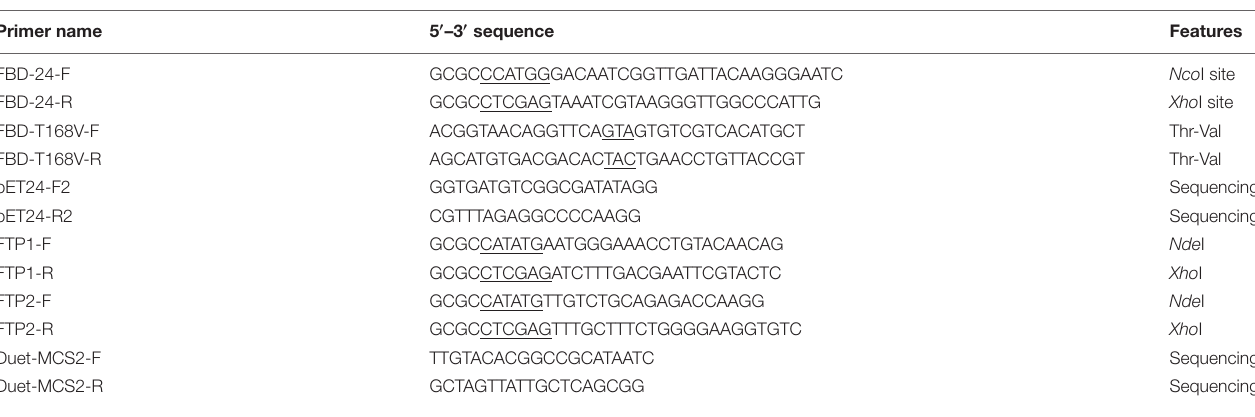
TABLE 3 | Oligonucleotides used in this